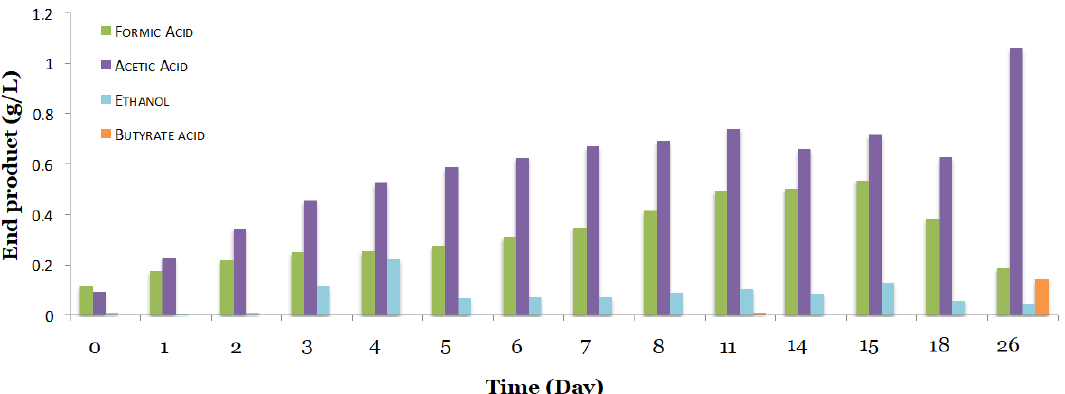
Figure 2. End product identified for Clostridium carboxidivorans wild type P7 in the 1754-B modified medium. Butyrate production was detected, but not until after day 26.